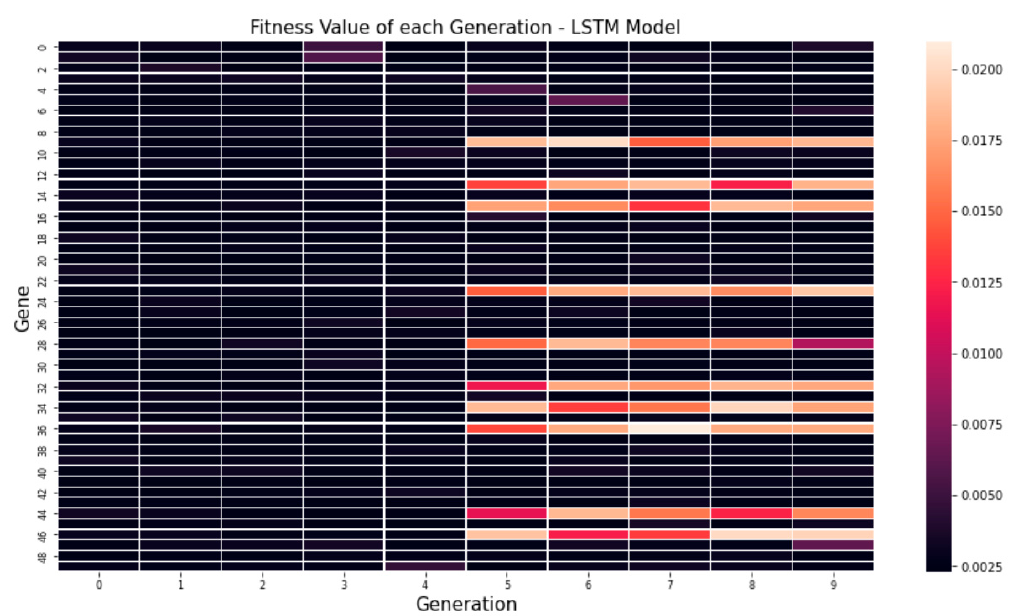
Figure 6. Visualized evaluation functions for each generation: RNN model.